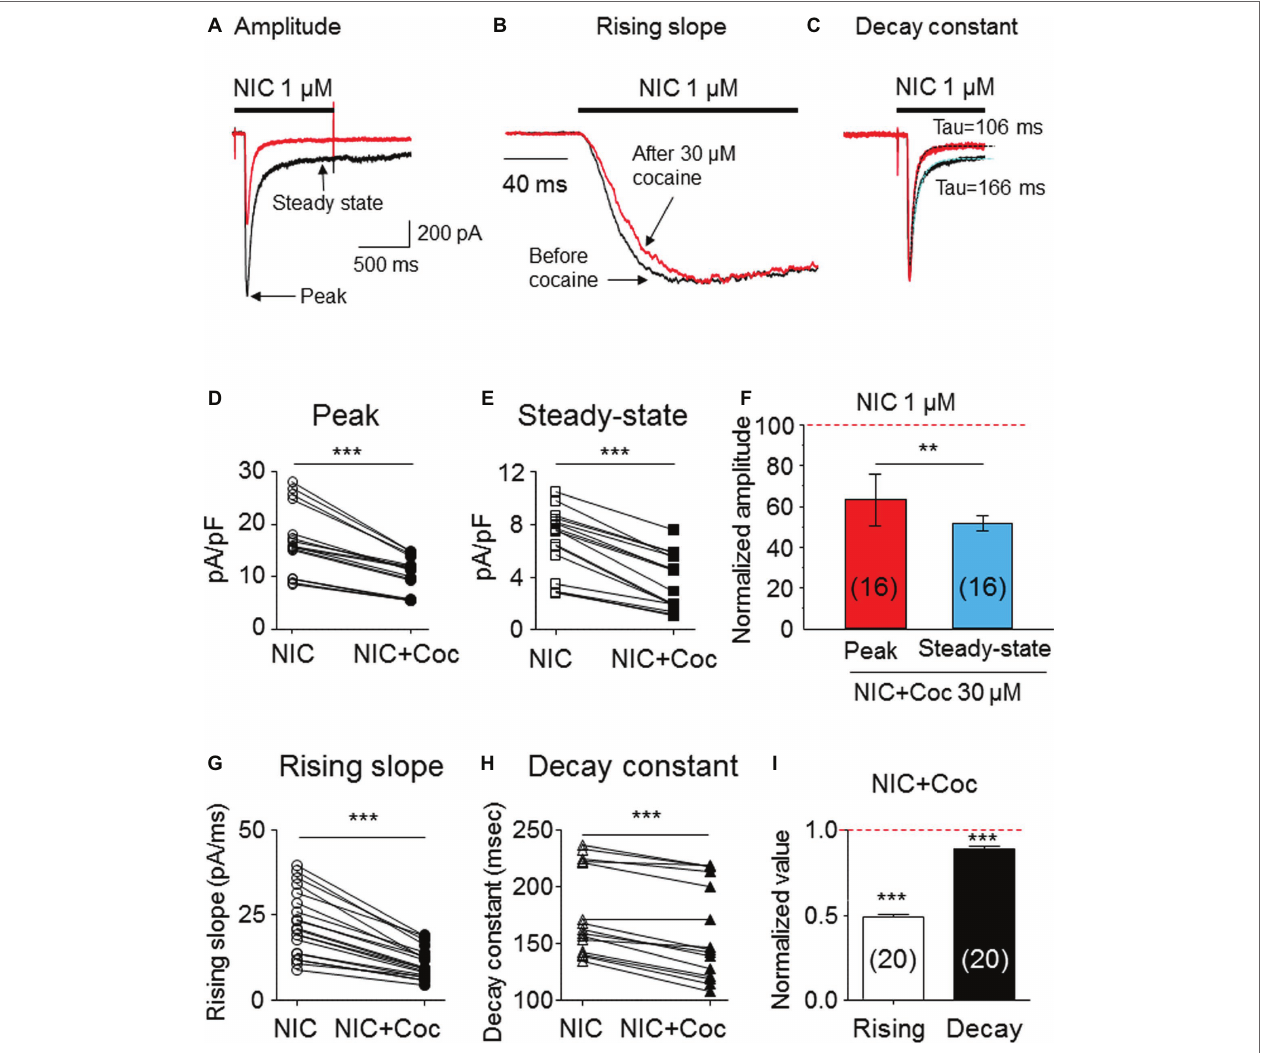
FIGURE 3 | Kinetic analysis of cocaine’s effect on α 6*-nAChR-mediated currents. (A) Superimposed whole-cell current traces before (black) and after (red) cocaine exposure showing a reduced peak and steady-state components. (B) Normalized peak current and expanded time scale to show the rising slope before (black) and after (red) cocaine exposure. (C) Single exponential fitting showed the whole-cell current decay time constant during nicotine exposure before (black) and after (red) cocaine exposure. Statistical comparison of the peak (D) and steady-state (E) components before and after cocaine exposure showed that a cocaine-induced reduction of either peak or steady-state components was highly significant, and the inhibitory effect on steady state was greater (F) . (G) Cocaine significantly reduced whole-cell current rising slope. (H) Cocaine significantly accelerated whole-cell current decay constant. (I) The representative inhibitory ratio of cocaine on a whole-cell current rising slope and decay constant. The horizontal dashed lines in F and I indicate the level of nicotine-induced whole-cell current before cocaine exposure, which was normalized to 1.0. ** p < 0.01 and *** p <